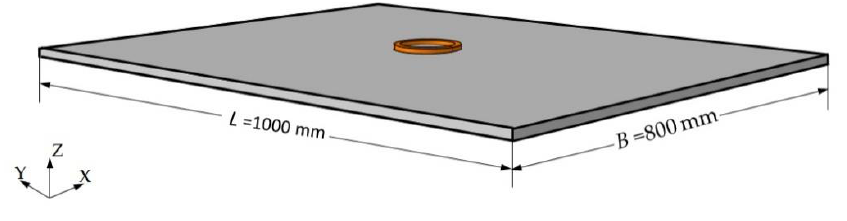
Figure 10. Coupling calculation model.